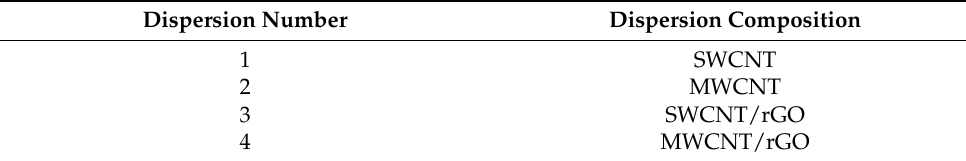
Table 1. Dispersions’ compositions. Dispersion Number Dispersion Composition 1 SWCNT 2 MWCNT 3 SWCNT/rGO 4